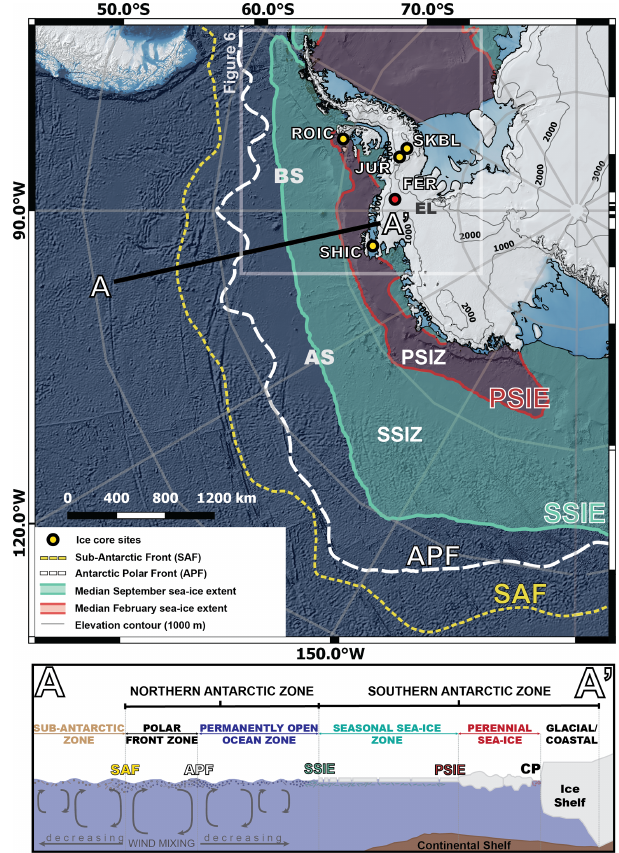
Figure 1. Map showing the ice core sites and oceanographic fea- tures considered in this study. The yellow circles show the locations of the four ice core sites. The red circle shows the location of the Ferrigno ice core (Allen et al., 2020). The pale green line shows the median September sea ice extension between 1980–2010CE and represents the seasonal sea ice edge (SSIE). The red line shows the median February sea ice extension between 1980–2010CE and represents the perennial sea ice edge (PSIE). A–A (cid:48) presents a schematic cross section including the standard oceanographic fea- tures across the Amundsen–Bellingshausen seas (schematic cross section adapted from Allen et al., 2011). The grey box delineates the region presented in Fig. 6. SAF: Sub-Antarctic Front. APF: